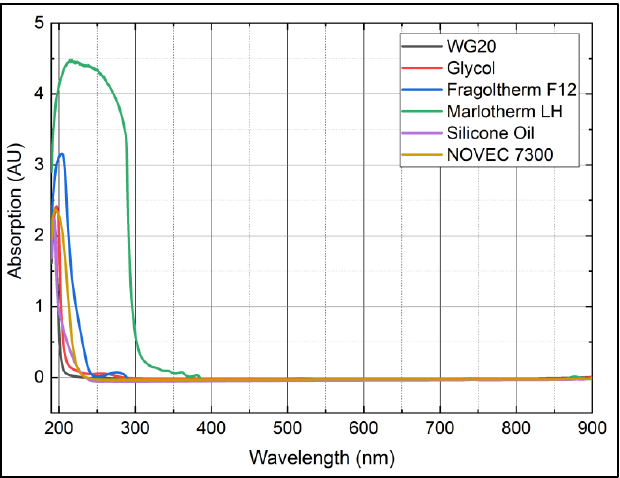
Figure A1. Absorption of various heat transfer fluids, 293 K. The glycol concentration-dependent spectral shift of Eosin-Y (9.38 mg/L) in wa- ter/glycol is shown in Figure A2. The measurements revealed a linear shift of the peak towards longer wavelengths with an increasing glycol concentration.